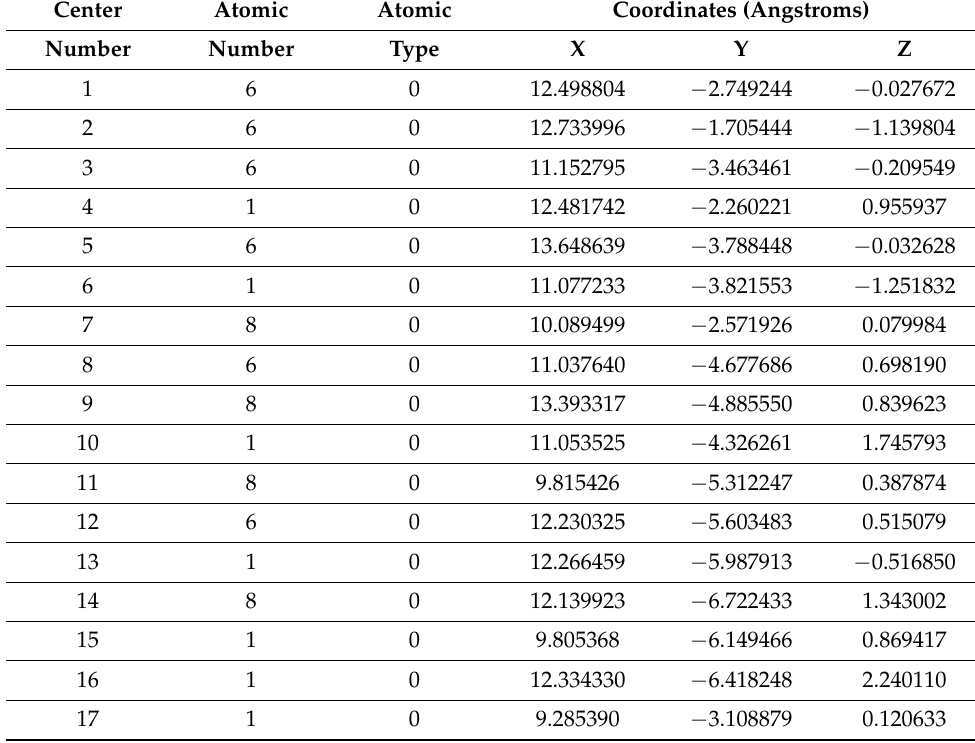
Table A1. Complex I. LiI-I 2 in the dextrin